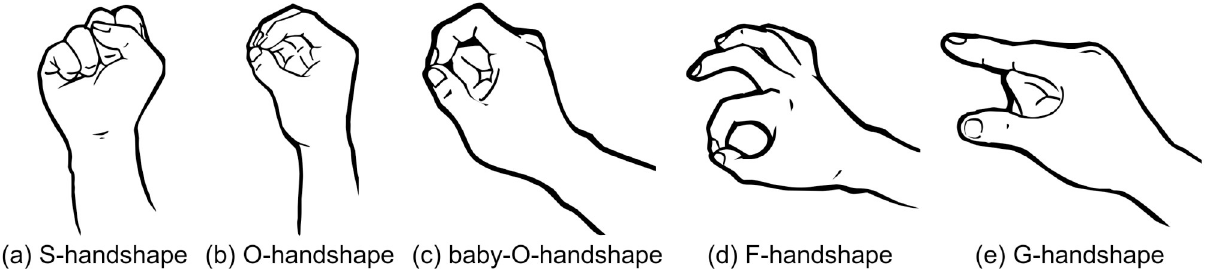
Fig 3. Thumb contact, flexion of unselected fingers. Example ASL handshapes displaying contact between the thumb and the fingers (a–d, but not e). Signs with thumb contact were significantly more likely to be interpreted as transitive than signs without. Handshapes (c) and (d) differ minimally in the flexion of the unselected fingers (in this case, the middle, ring, and pinky fingers). The unselected fingers are closed in (c) but extended in (d). The furling of the unselected fingers tended to characterize intransitive productions across the entire dataset. (To note, since all of the fingers are selected in (a) and (b), there are no unselected fingers.) Finally, each handshape, a–d, is congruent with a type of grasp: (a) and (b) are power grasps, congruent with the agentive movement of or action affecting an object (JUGGLE, IMPACT [‘to hit’]) or tool (SAW [‘to saw’], SHAVE). (c) and (d) are precision grasps, most consistent with tool usage (e.g., WRITE, STIR). Images were generated from the sign language handshape font created by CSLDS at